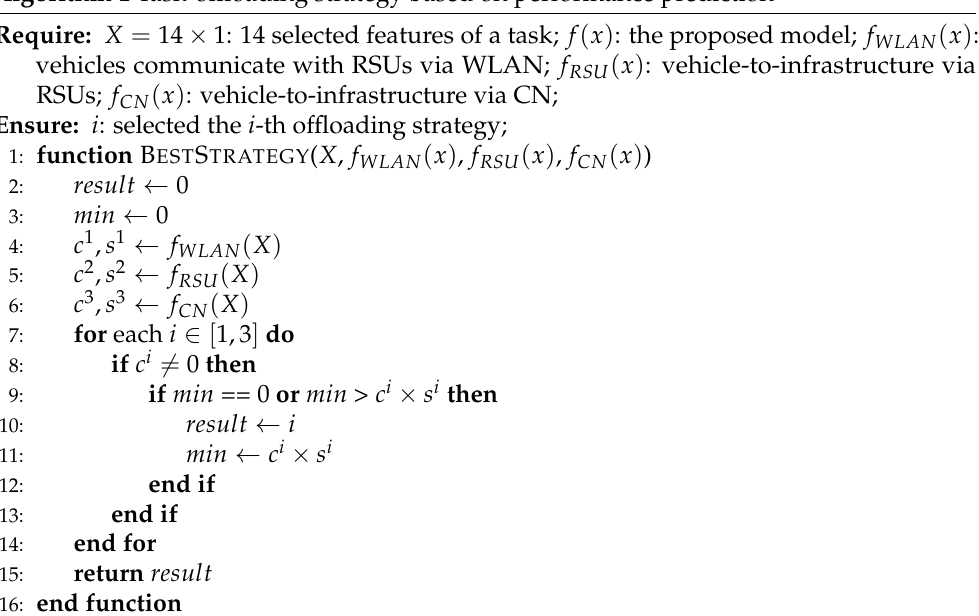
Algorithm 1 Task-offloading strategy based on performance